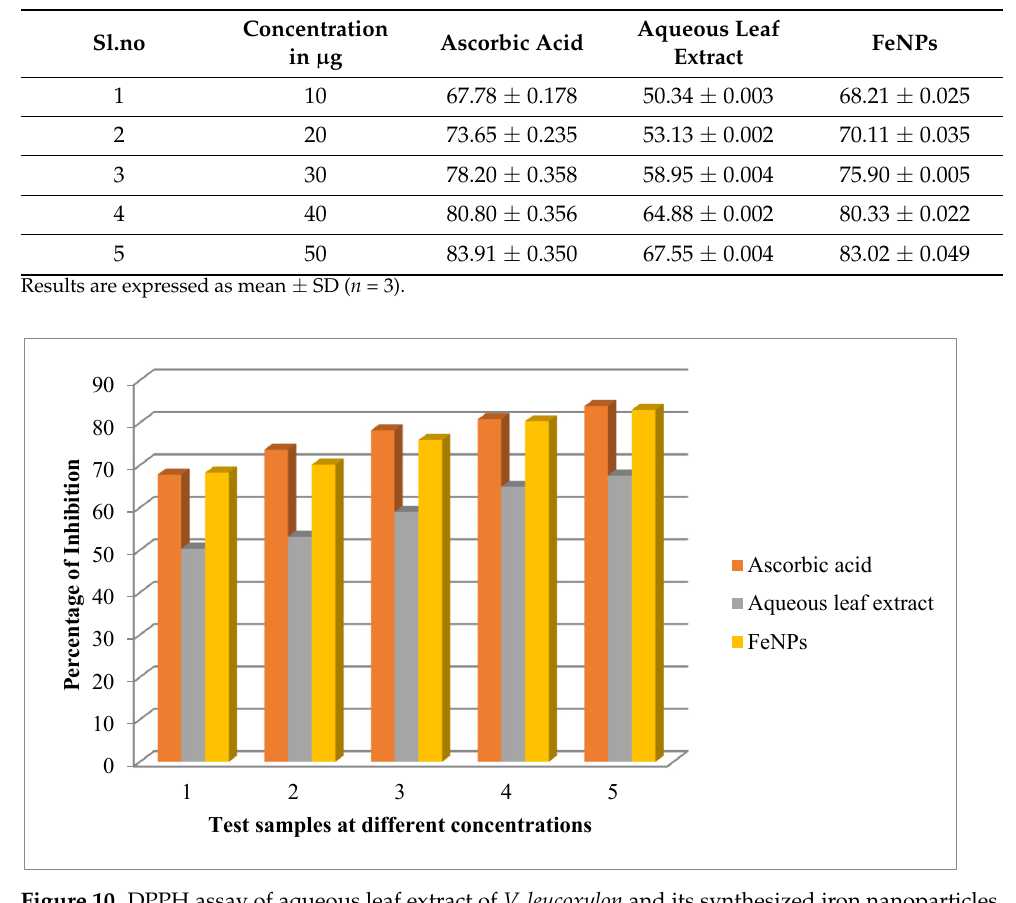
Figure 10. DPPH assay of aqueous leaf extract of V. leucoxylon and its synthesized iron nanoparticles. Redox reactions involving molybdenum and molybdenum ligand antioxidants can be quantified using the PM test. It entails a longer duration of incubation at a higher temperature, which alters the auto-oxidation reaction in the mixture. It directly measures the extracts’ lowering potency. At acidic pH, the reaction mixture creates a green phos- phomolybdeum colored complex, which is detected at 695 nm. The reducing activity of extracts and conventional drugs increased as concentrations increased. In the current inves- tigation, known amounts of aqueous leaf extracts of V. leucoxylon and its generated FeNPs, as well as ascorbic acid as a standard, were exposed to PM screening. Iron nanoparticles demonstrated greater action than aqueous leaf extracts of V. leucoxylon , while conventional ascorbic acid demonstrated the highest activity. (Table 5 and Figure